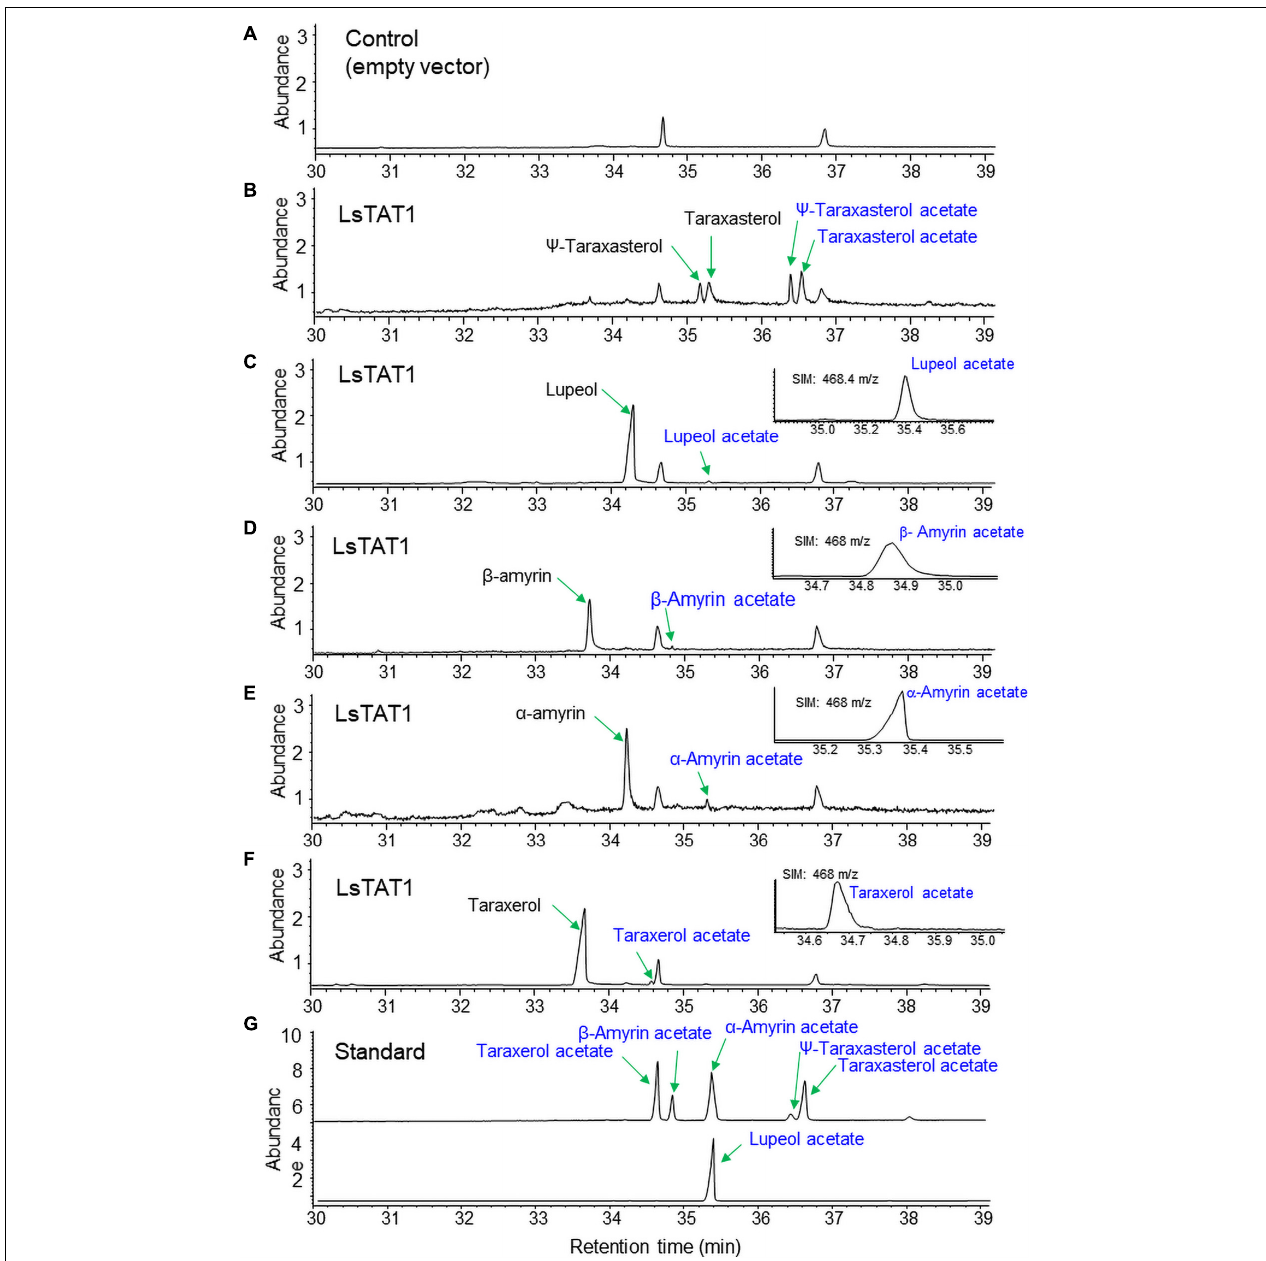
FIGURE 5 | In vitro conversion of triterpenes to triterpene acetates by the reaction of microsomes from yeast expressing Ls TAT1. (A) Gas chromatography–mass spectrometry (GC/MS) chromatograms of the control of an assay with the microsome of yeast cells with an empty vector. (B–F) GC chromatograms of the reaction products of microsomes with taraxasterol and ψ -taraxasterol (B) , lupeol (C) , β -amyrin (D) , α -amyrin (E) , and taraxerol (F) . (G) GC chromatograms of standards of triterpene acetates. The inserted panels (C–F) are single ion mode (SIM) chromatograms of lupeol acetate, taraxerol acetate, β -amyrin acetate, and α -amyrin